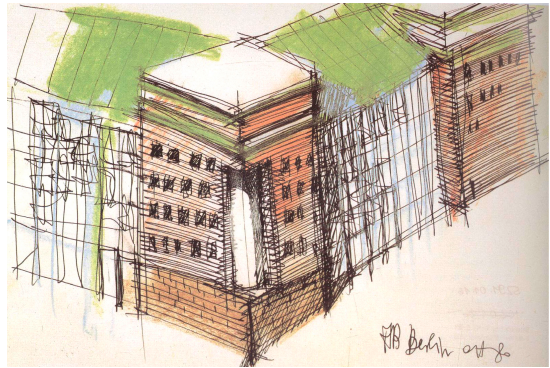
Figure 1. Aldo Rossi, plate for IBA 84. Sketch of the building at the corner between Kochstraße and Wilhelmstraße, Block 10,